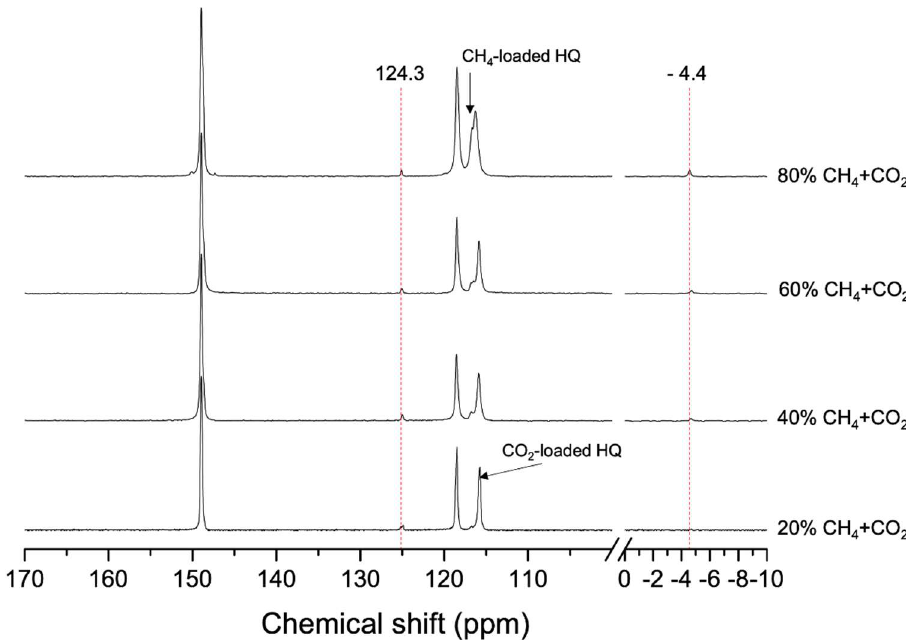
Figure 5. Solid-state 13 C NMR spectra for the HQ samples after reaction with binary (CH 4 + CO 2 ) gas mixtures of various compositions at 40 bar. Two dotted lines at 124.3 and −4.4 ppm indicate the carbon signals from CO 2 and CH 4 in clathrate cages, respectively.